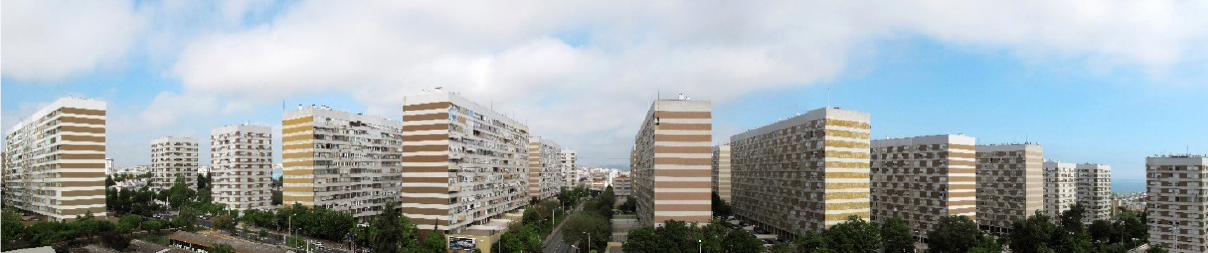
Figure 6. Fernando Silva’s Portela District, Lisbon, Portugal. Source: Courtesy of Bruno Macedo